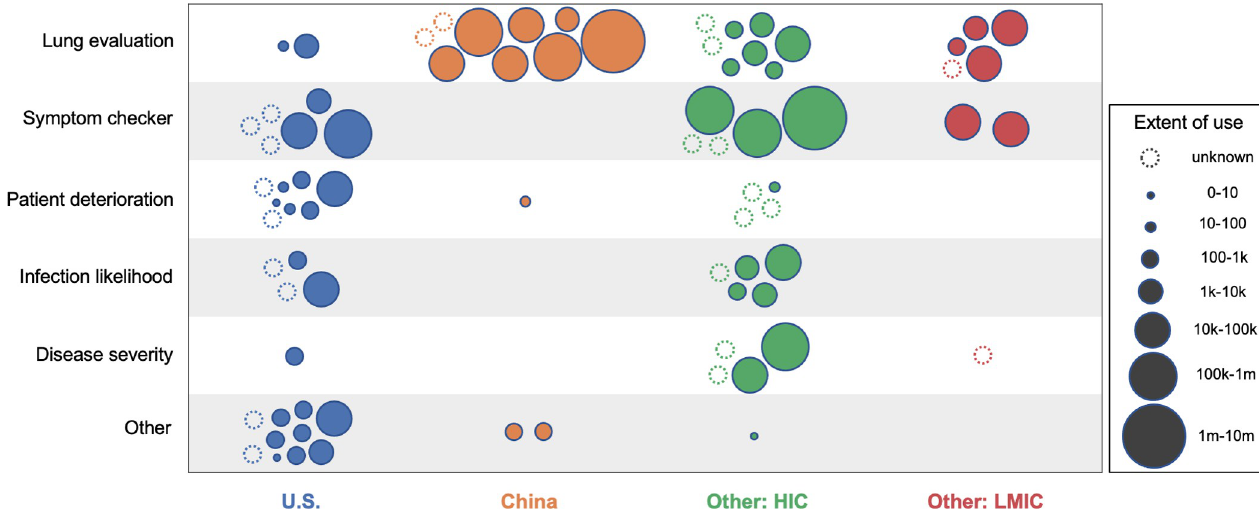
Fig 3. Extent and location of use in the COVID-19 response, by application category. Note: Scale of use reflects numbers of patients or related proxy measures. 10 applications were used in multiple country categories and are represented by multiple bubbles. We were unable to find exact country or scale of use for 3 online symptom checkers; these are represented by ‘unknown’ bubbles assigned to the country category where they were developed.